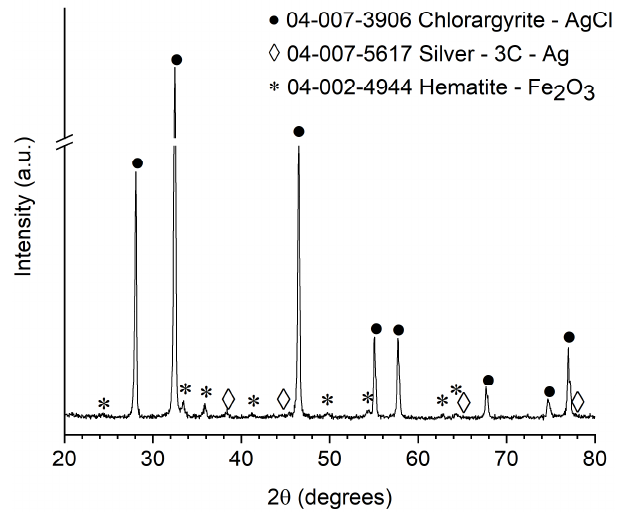
Figure 2. XRD pattern of the Ag/AgCl/α-Fe 2 O 3 composite. α-Fe 2 O 3 nanowires XRD pattern can be found in the Supplementary Material (Figure S1).